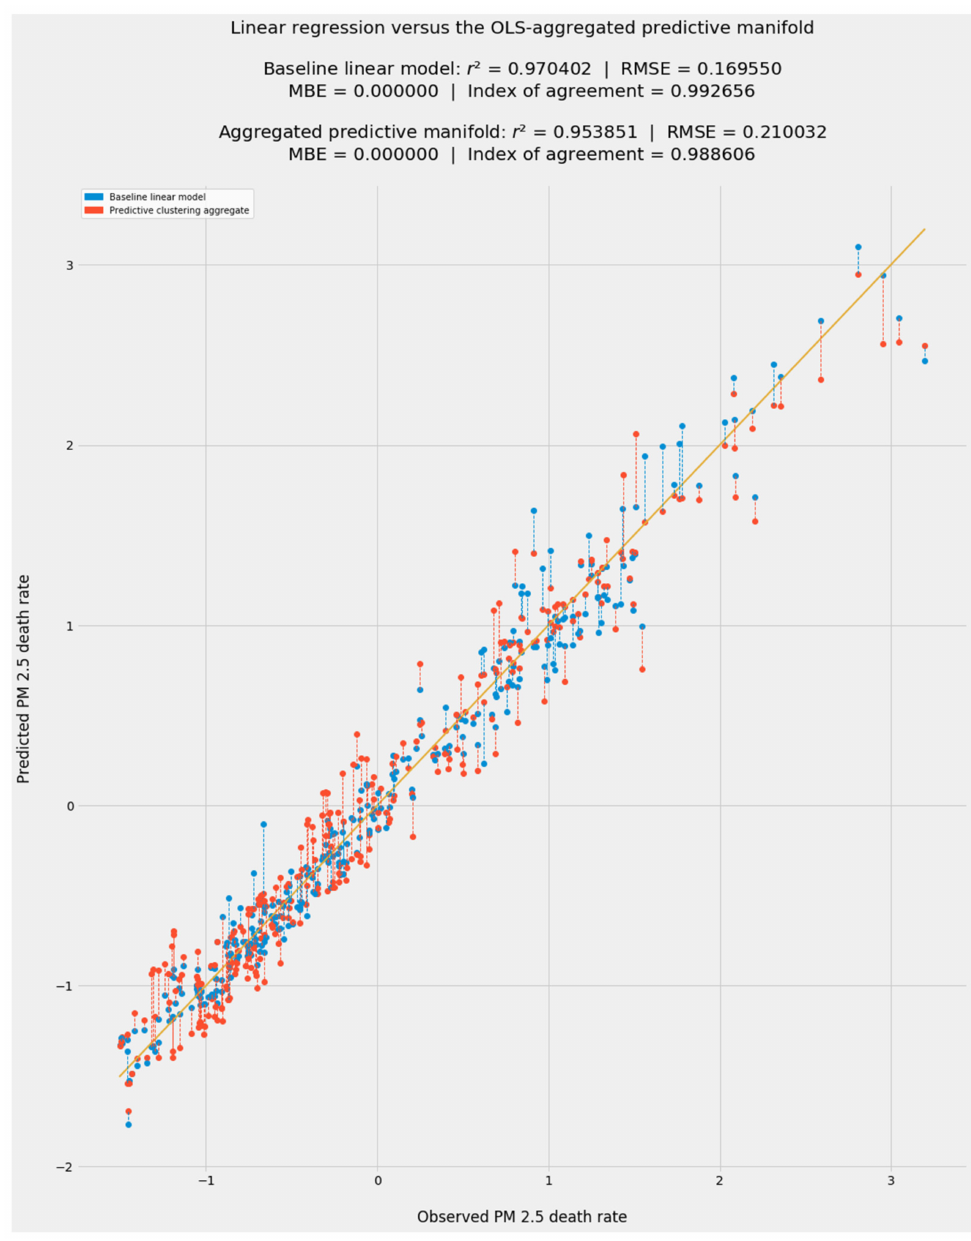
Figure 14. A “sundew plot” comparing conventional OLS with aggregated predictions through unsupervised machine